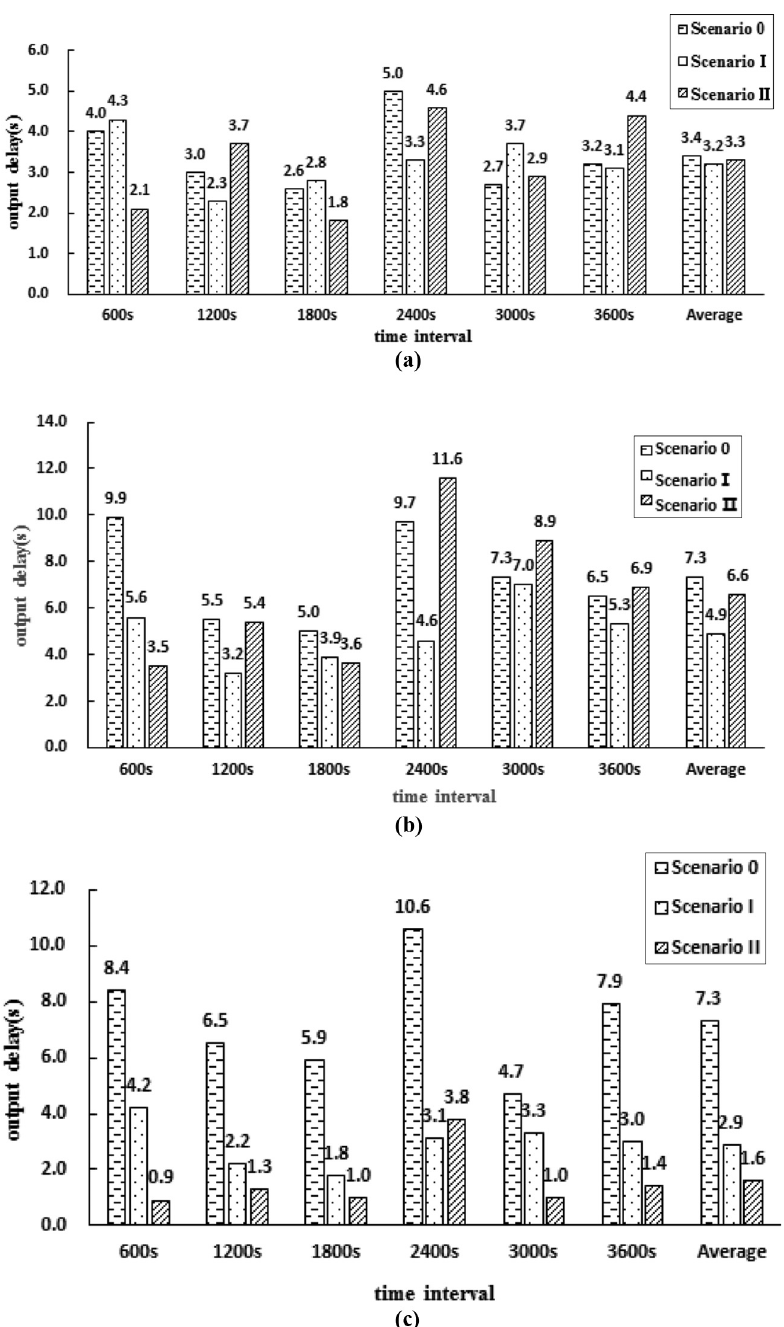
Figure 14 Delay output histogram for Scenarios 0, I and